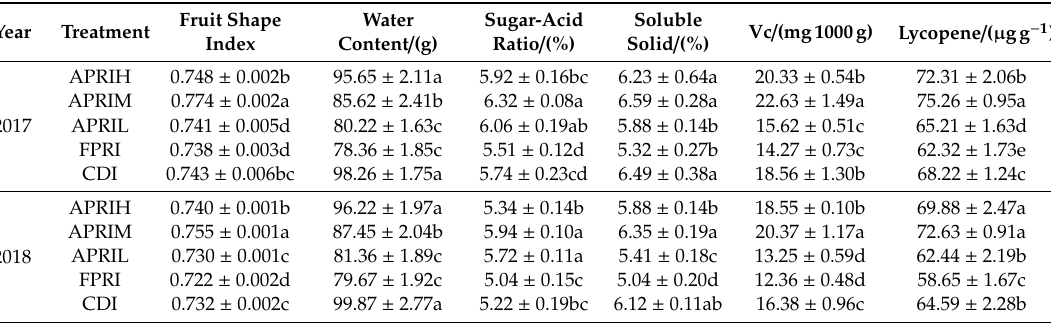
Table 4. Processing tomato qualities under di ff erent